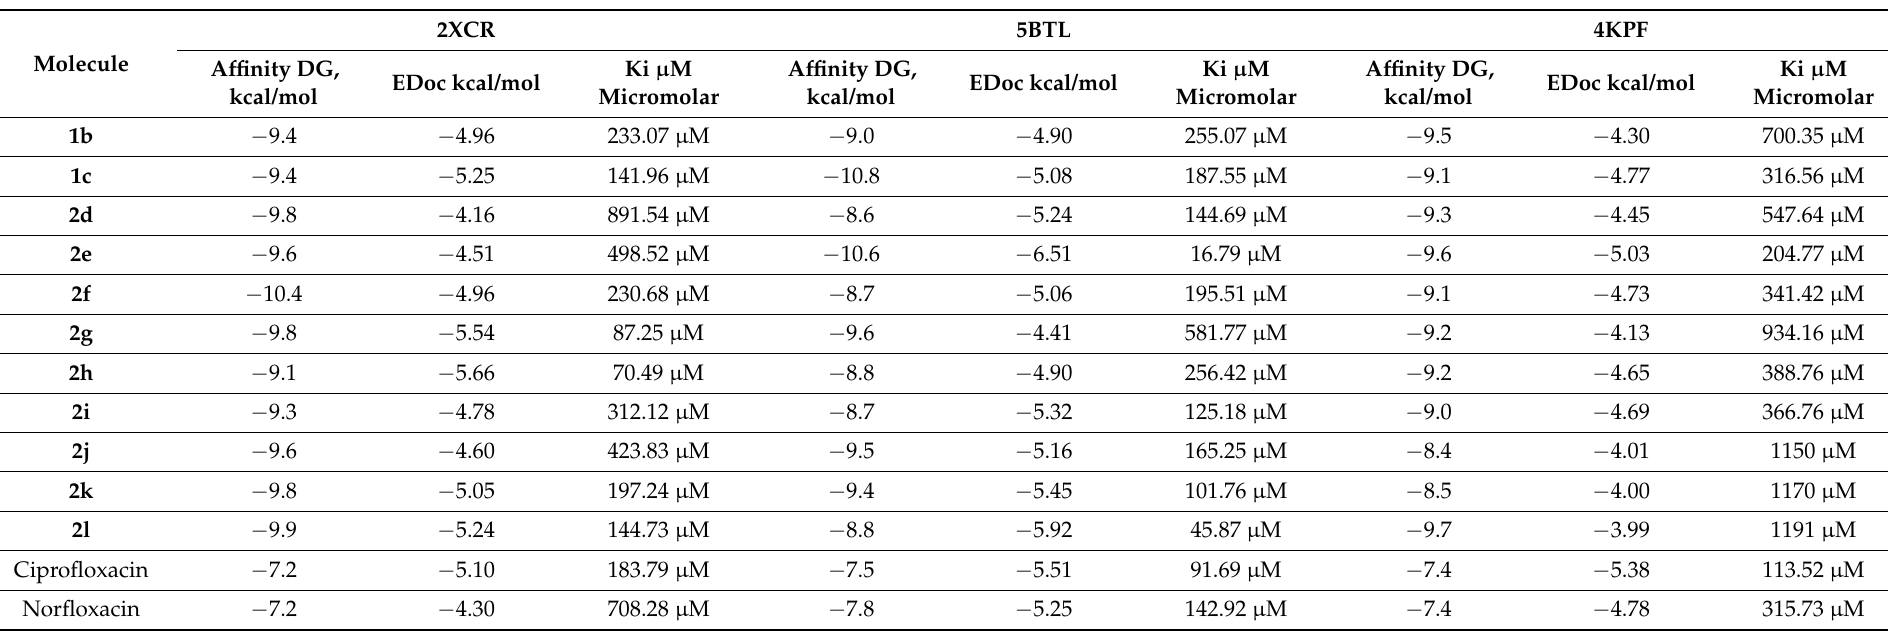
Table 2. The values of affinity DG, free binding energy, and binding coefficients for the best conformational positions of the test compounds in combination with biotargets (PDB ID: 2XCR, 5BTL,